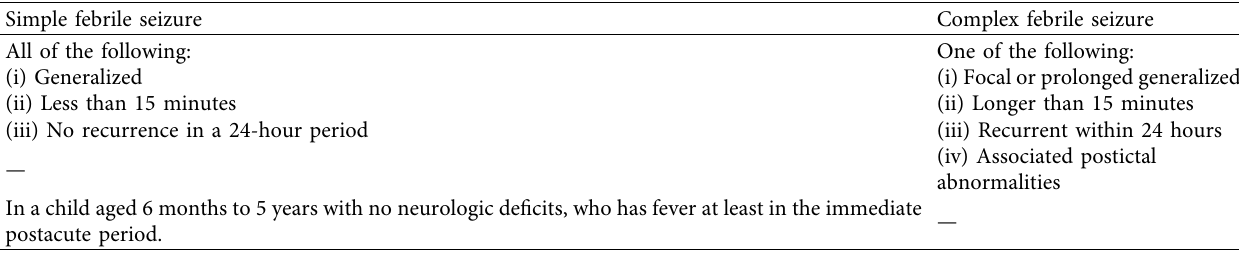
Table 1: Classification of febrile seizures